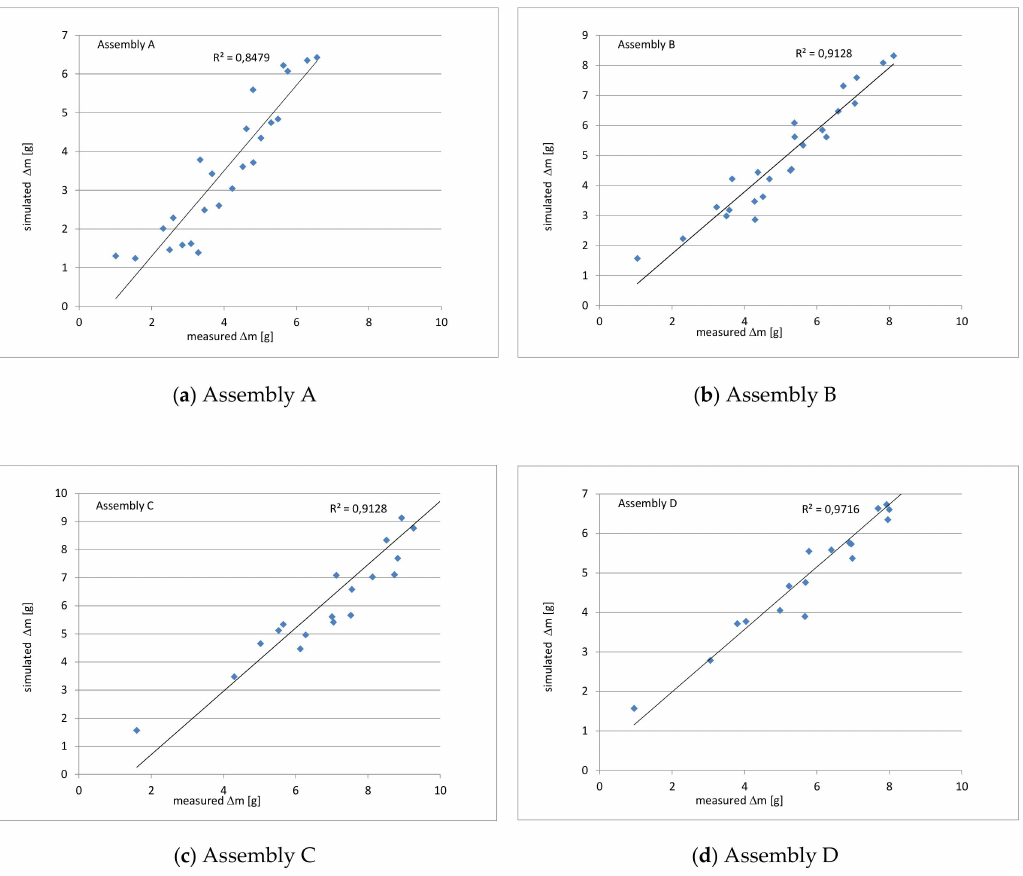
Figure 10. The correlations between measured and simulated results: ( a ) Assembly A; ( b ) Assembly B; ( c ) Assembly C; ( d ) Assembly